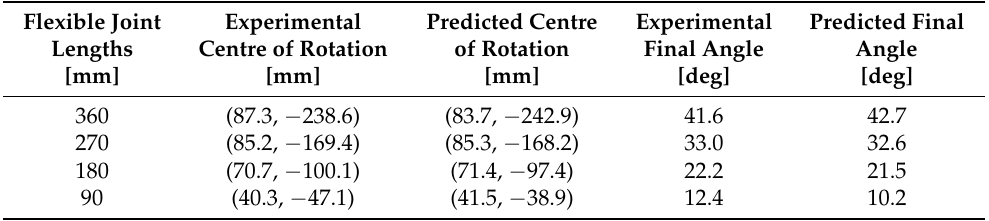
Figure 9. Picture of the experimental setup with added notations. Table 1. Experimental and predicted position of rotation centre and final end angle for four lengths of flexible joint.